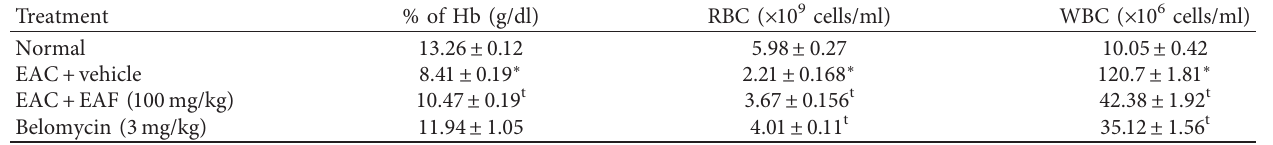
Table 2: Effects of EAF and standard bleomycin on blood parameters of tumor-bearing and normal mice. Treatment